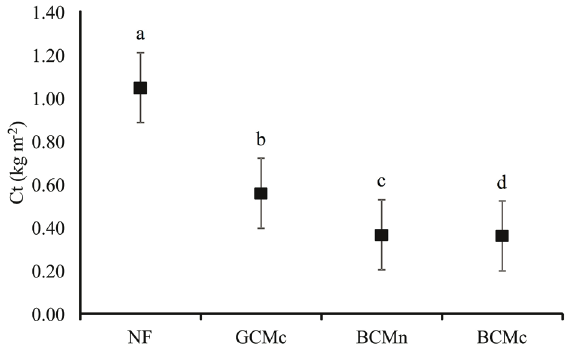
Figure 2 - Mean and confidence interval (95%) of stock carbon per area in the fragment of native forest (NF) and in areas under the sugarcane with burn and manual harvest (BMn), sugarcane with burn and mechanized harvest (BMc) and sugarcane without burn and mechanized harvest (NBMc). Different letters represent significant differences in the Tukey test (p <